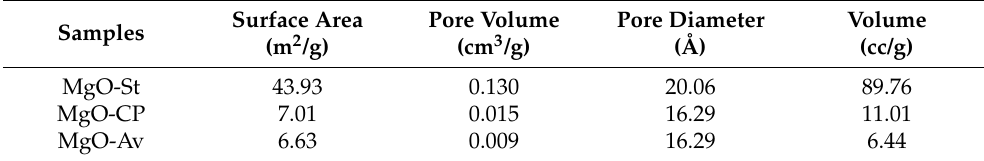
Table 1. Textural properties of the synthesized MgO.